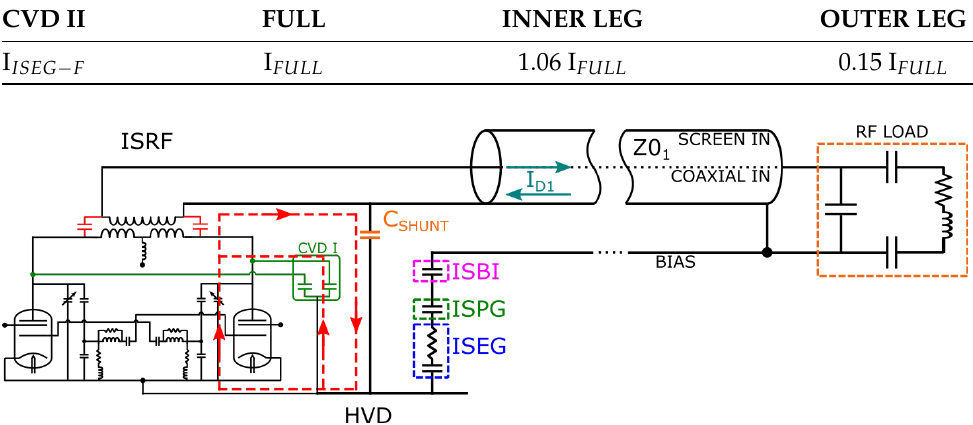
Figure 8. Shunting of the common mode current through a capacitor installed between RF coaxial line outer conductor and ISRF cubicle (HVD).